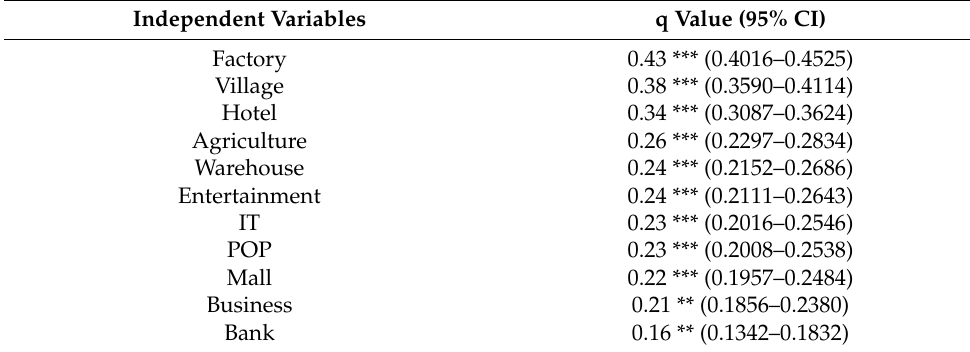
Table 4. Results of the factor detection. (Mean q value =